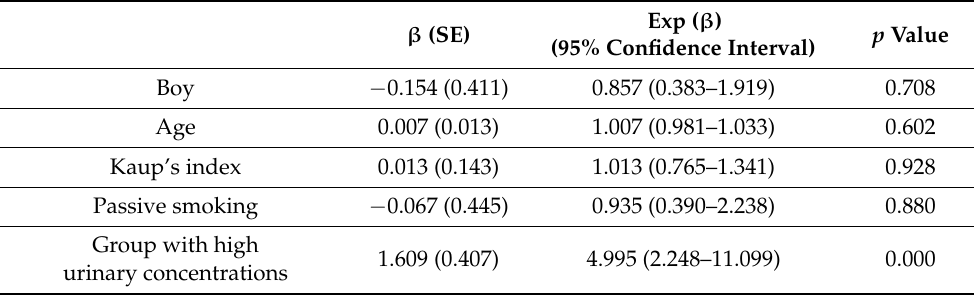
Table 5. Multiple logistic analysis of atopic dermatitis with variables including the urinary concen- tration of